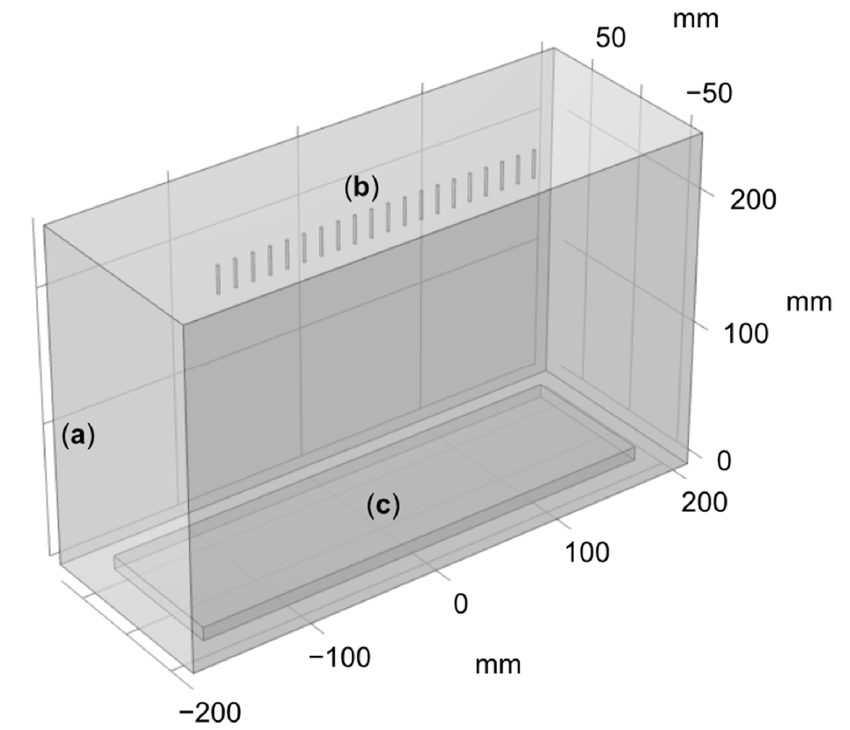
Figure 10. COMSOL 3D geometry, (a) air domain, (b) needles, ( c ) collector.